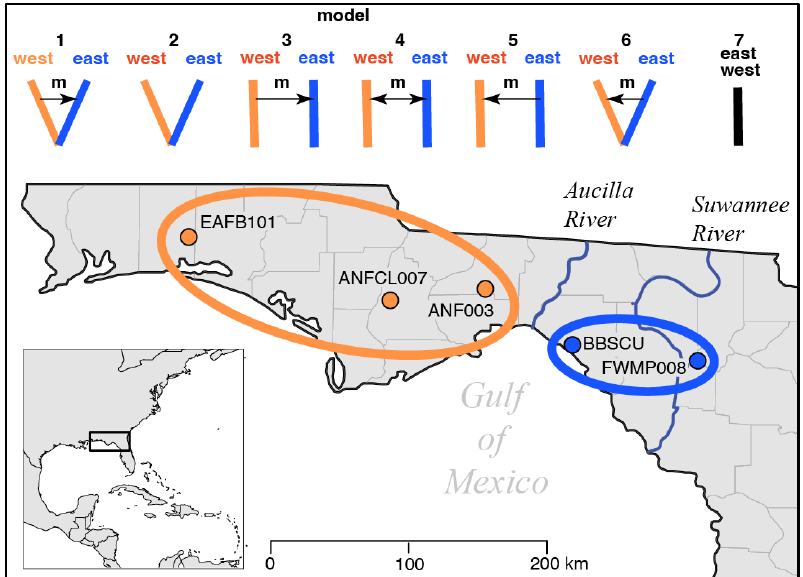
Figure 2. Top: seven models tested in Migrate analysis. Model 1: split with immigration to the east; 2: split without immigration; 3: immigration to the east only; 4: immigration to the east and west; 5: immigration to the west only; 6: split with immigration to the west only; 7: panmixia. Orange circles represent populations combined into a panhandle group and blue circles represent peninsular populations that were combined.